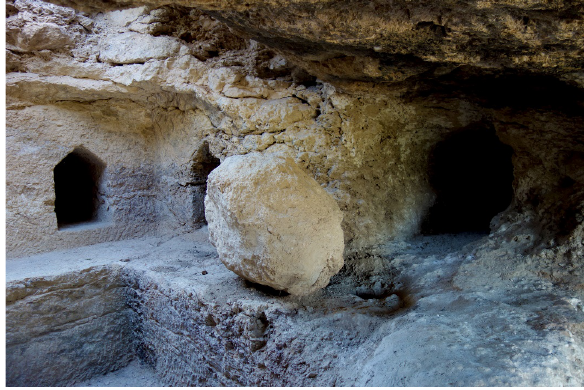
Figure 12. Fallen rock of the burial chamber.